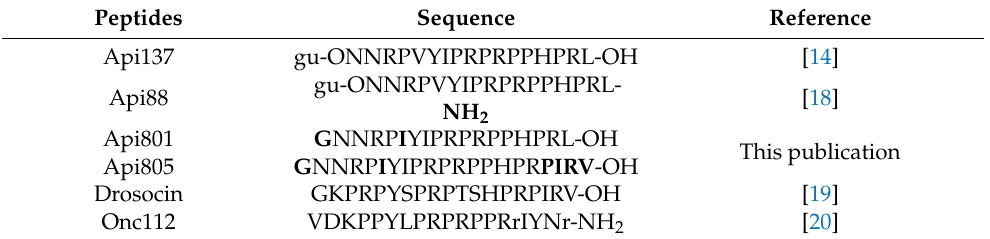
Table 1. Sequences of all studied PrAMPs. Gu, O, and r denote 1,1,3,3 tetramethyl guanidine, ornithine, and D -arginine, respectively. Residues substituted in Api137 are marked with bold letters. Peptides Sequence